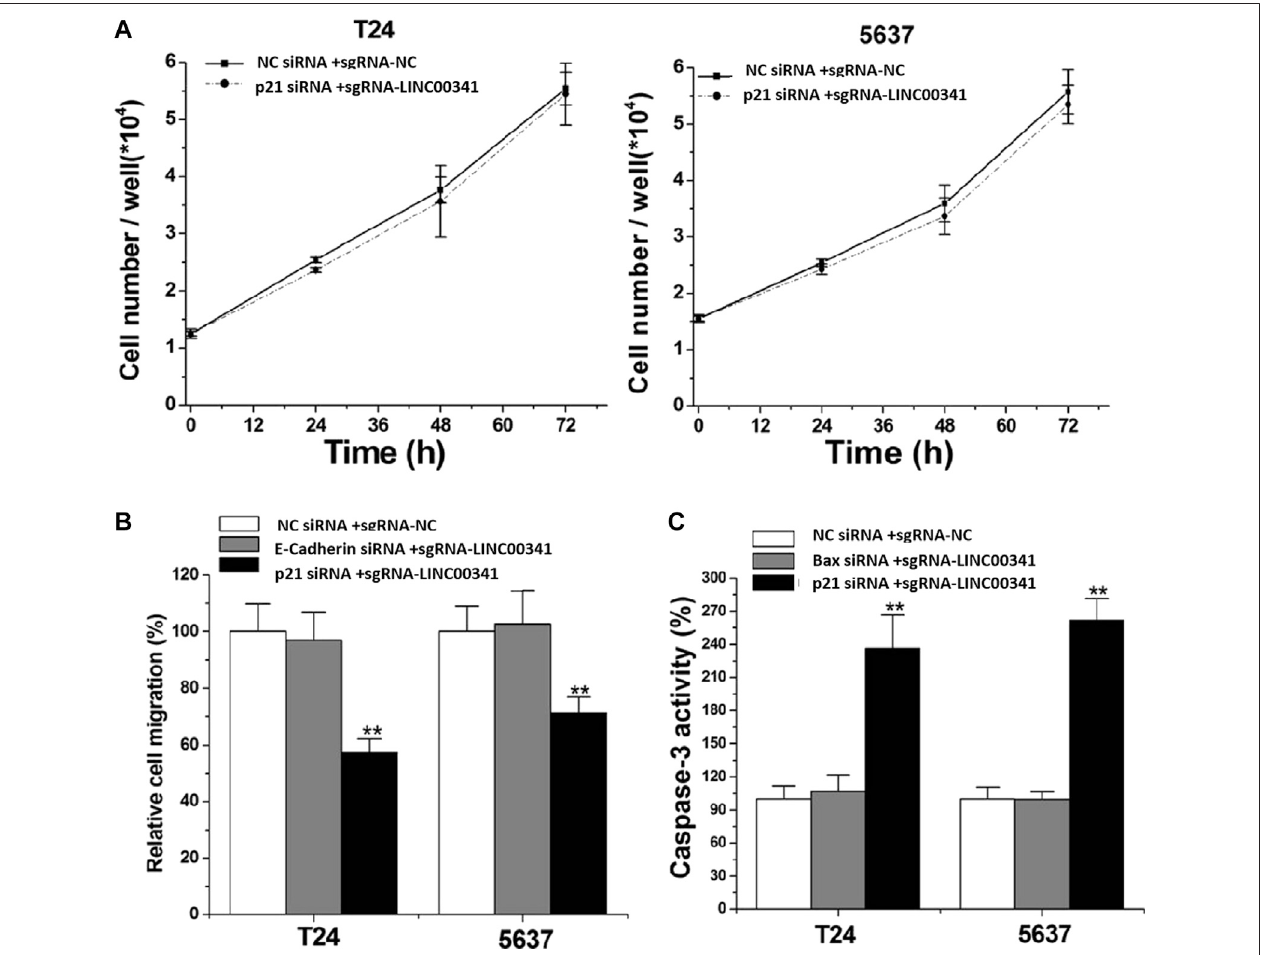
FIGURE 7 | Knockdown of LINC00341 by CRISPR-CasRx induced cellular phenotypic changes via p21, Bax as well as E-cadherin regulation. After siRNA transfection, CCK-8, wound healing as well as ELISA analyses were respectively employed to detect cell proliferation, migration as well as apoptosis. (A) . p21 siRNA eliminatedtheproliferationinhibitoryeffectinducedbyLINC00341sgRNAinT24aswellas5,637( p > .05). (B) .E-cadherinsiRNAeliminatesthemigrationinhibitoryeffect induced by LINC00341 sgRNA in T24 and 5,637, while p21 siRNA does not have this function. ** p < 0.01. (C) . Bax siRNA eliminates the apoptosis-promoting effect induced by LINC00341 sgRNA in T24 and 5,637, while p21 siRNA does not have this function. ** p < 0.01.